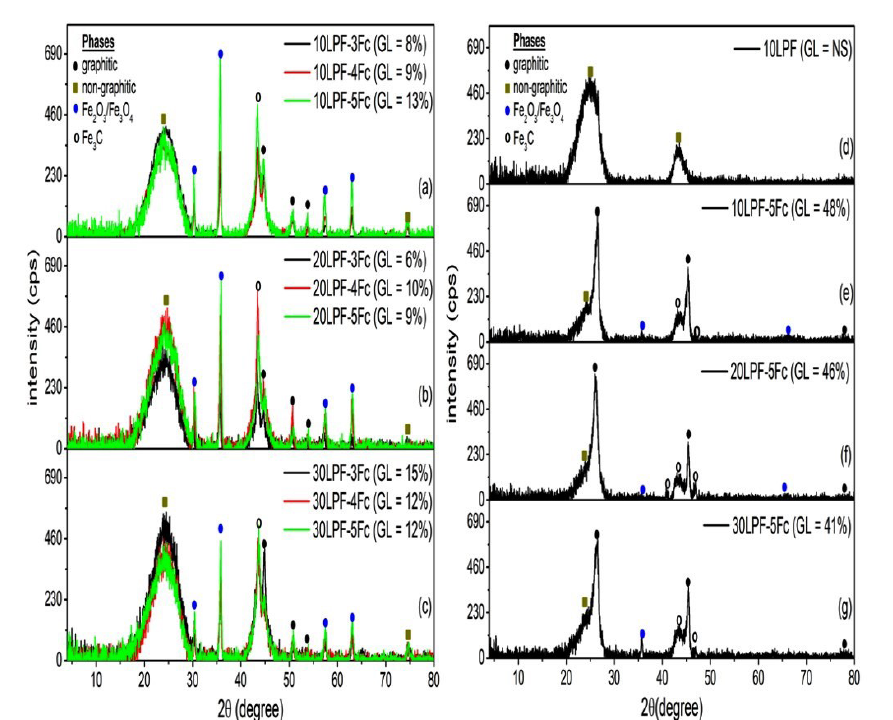
Figure 7. XRD profiles of carbons derived from lignin-phenol-formaldehyde resins containing ferrocene after pyrolysis at (a-c) 1000 °C, (d-g) 1500 °C for 5 hours. NS = not